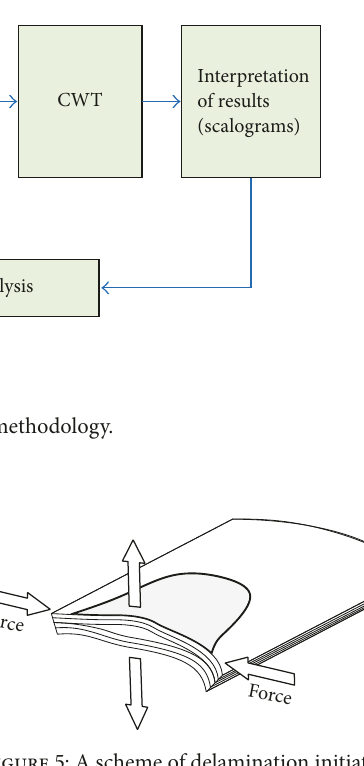
Figure 5: A scheme of delamination